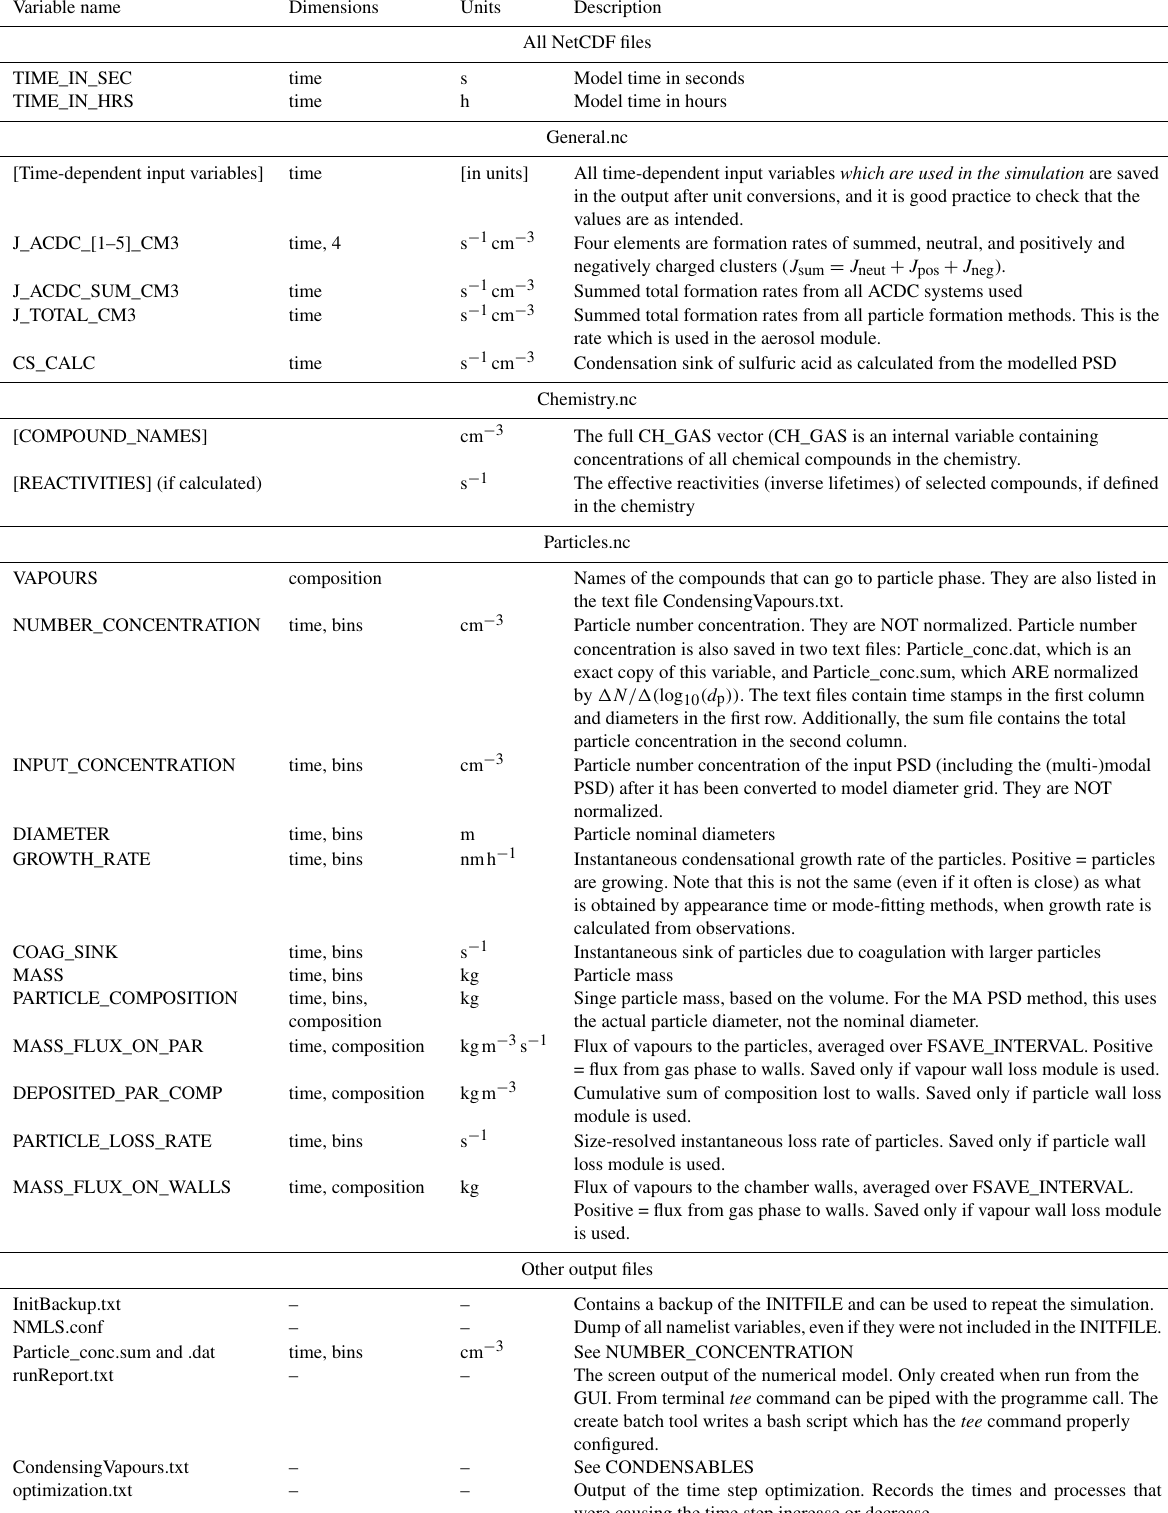
Table 2. Description the output file contents, dimensions and